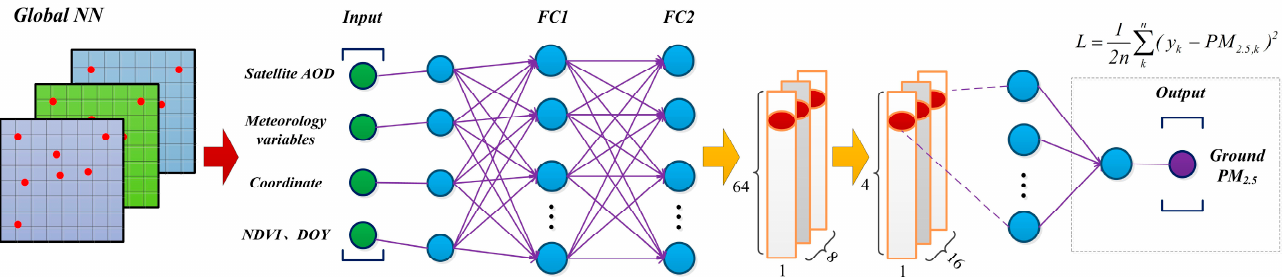
Figure 2. The flow of the dynamic routing algorithm.